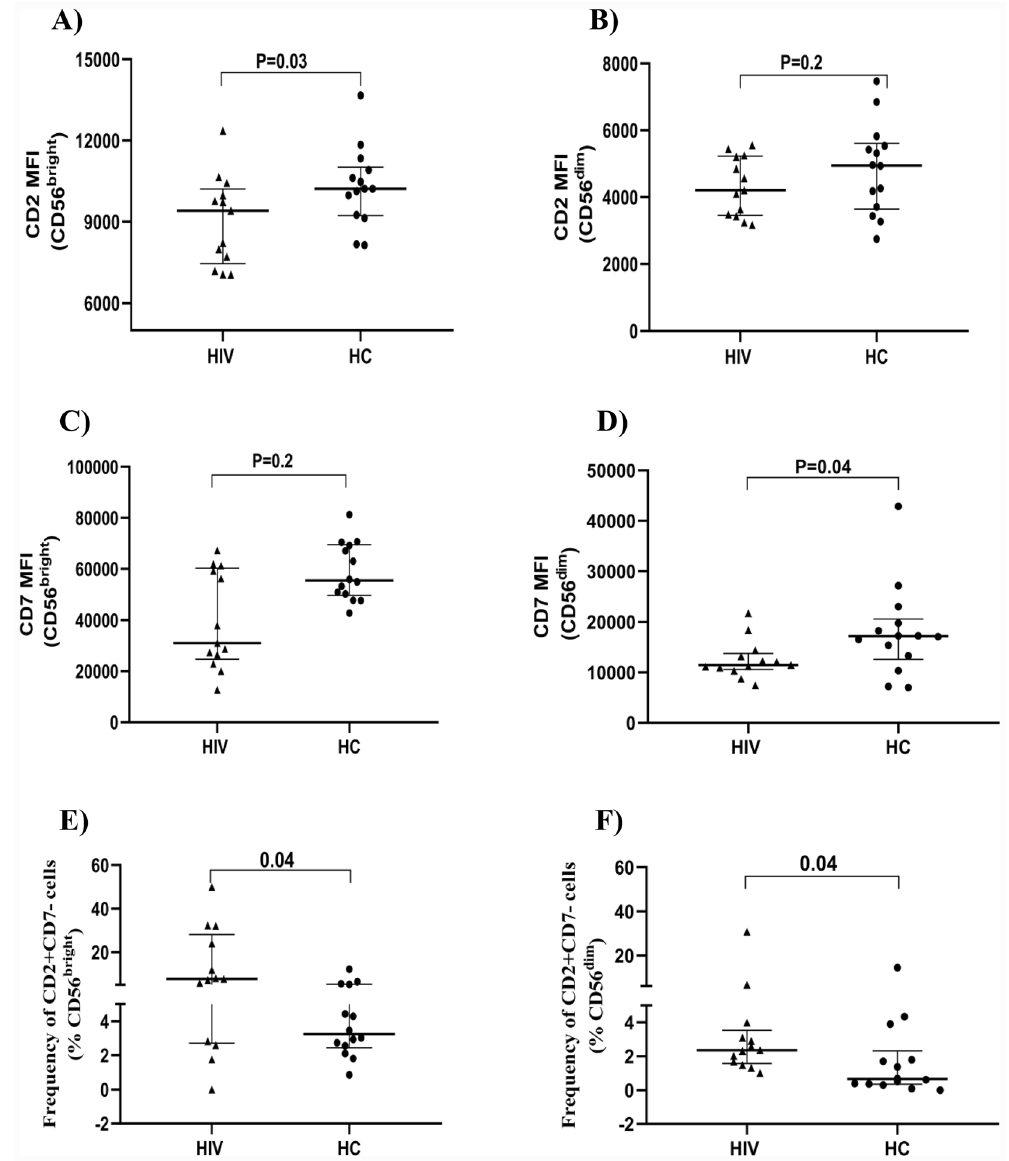
Figure 5. Expression of CD2 and CD7 by the subsets. The dot plot graph depicts the median fluorescent intensity of CD2 and CD7 on CD56 bright ( A , C ) and CD56 dim ( B , D ) NK cell subsets (HIV = 13, HC, 14 subjects). The frequency of CD7 − CD2 + cells among CD56 bright ( E ) and CD56 dim ( F ) subsets is depicted. Mann–Whitney tests were performed with a p-value < 0.05 considered statistically significant. The median and 25th and 75th percentile are indicated on each